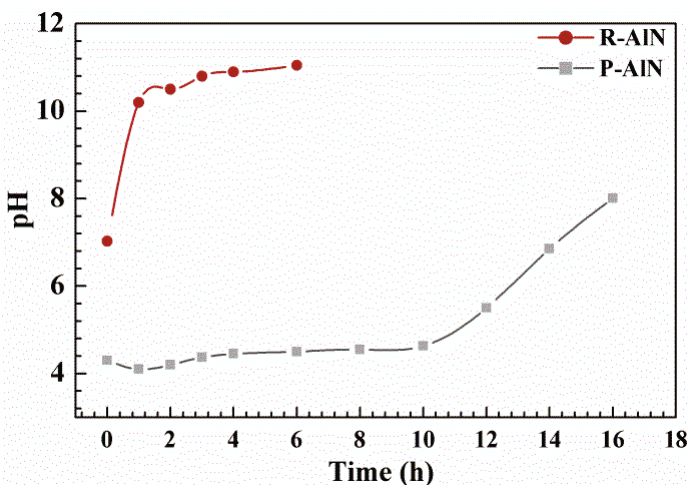
Figure 6. Change of R-AlN and P-AlN Powder pH value over time in 60 °C water-based medium. ysis, and is an important method to characterize the AlN crystal phase change. Conduct XRD characterization for R-AlN and P-AlN powder soaked in water-based medium with different times to further investigate the change of phase, as shown in Figure 7. It can be found that, the phase diffraction peak of R-AlN has completely changed after 1 h. Based on PDF standard card analysis, main hydrolysis products are Al(OH) 3 and AlOOH. However, P-AlN powder is still essentially the same as the AlN standard diffraction peak, without other obvious diffraction peaks. This indicates that the modification of AlN powder us- ing PVP- b -P (St/ITA) block copolymer has no impact on the AlN phase lattice, and the modification treatment only happens on the powder surface. In addition, within 10 h in 60 ◦ C, modified powder shows no impurity peak, and its peak pattern is the same as the original powder, without any hydrolysis phenomenon, but maintains AlN phase charac- teristics. The AlN powder after block copolymer modification displays good hydrolysis resistance